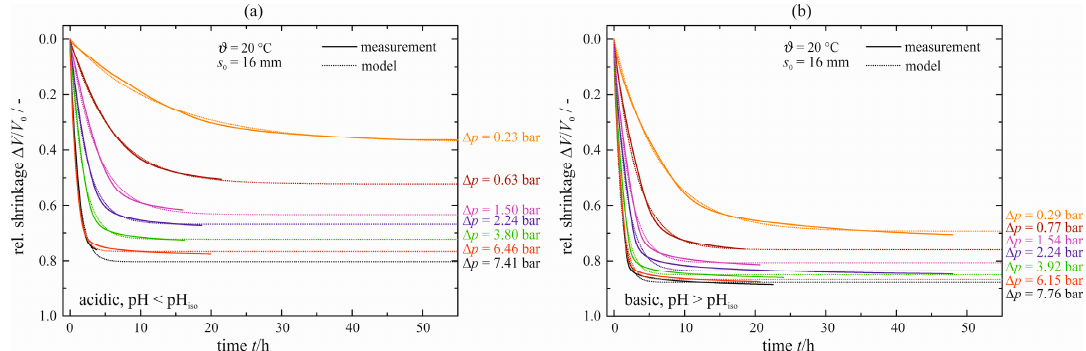
Figure 12. Relative shrinkage Δ V / V 0 of enforced syneresis for s 0 = 16 mm and ϑ = 20 °C, acid-catalyzed ( a ) and base-catalyzed ( b ).